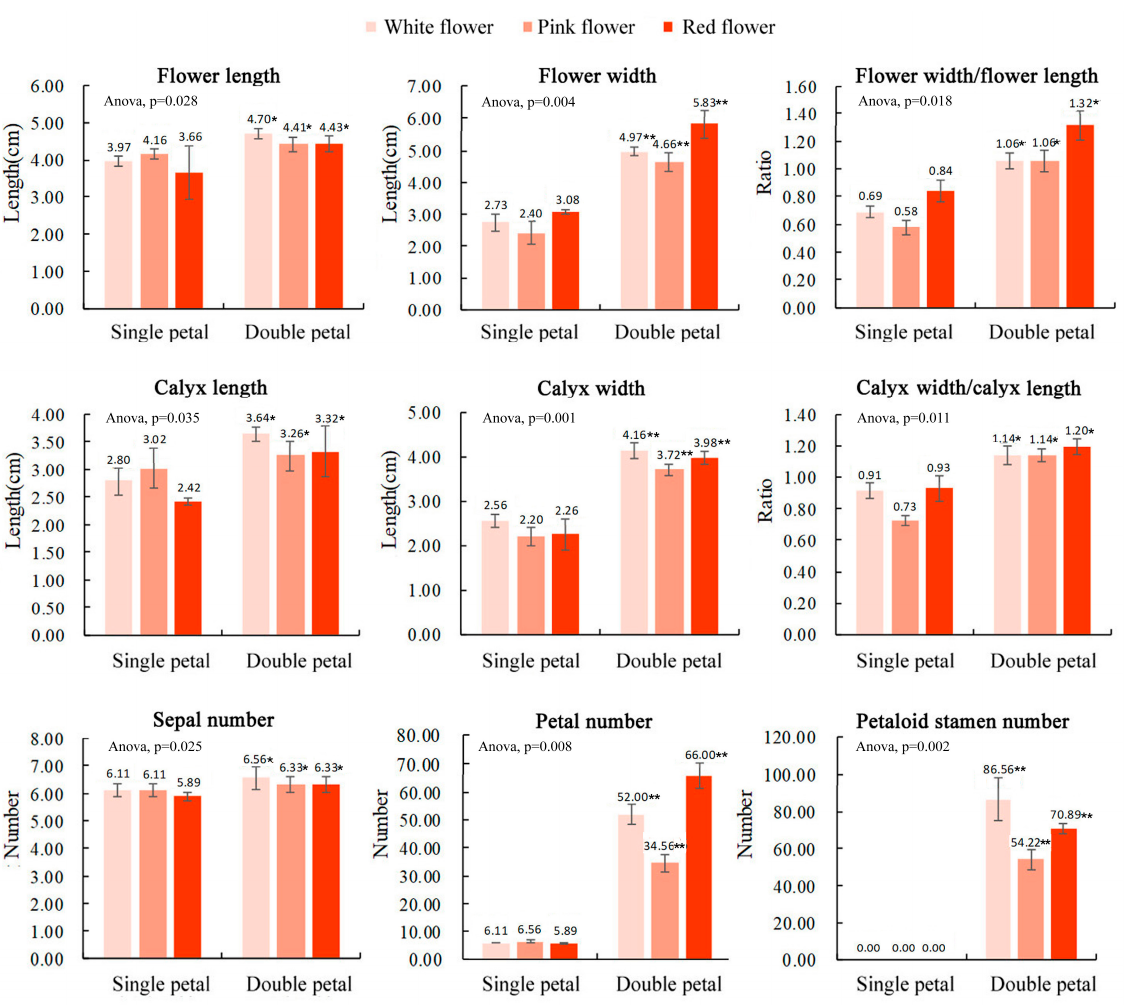
Figure 1. Morphological flower parameters of 6 ornamental pomegranate varieties. One asterisk and two asterisks indicated significant differences at p < 0.05 and p < 0.01, respectively, between the two types of flowers (single- and double-petals) according to the Duncan test. The standard deviation was also indicated.